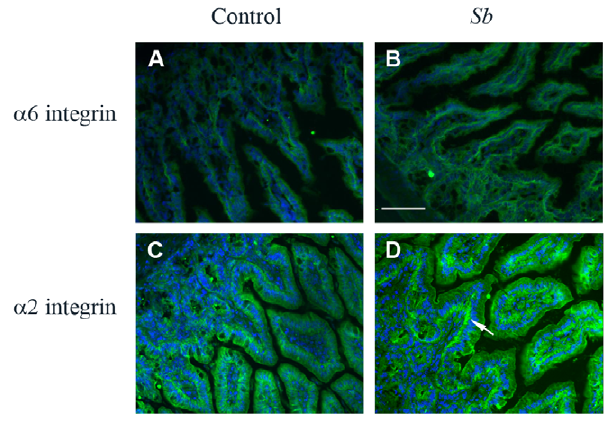
Figure 5. a 2 b 1 integrin is relocalized in the intestine of Sb force-fed mice. Intestinal tissues from control ( A and C ) or Sb force- fed mice ( B and D ) were immunostained with Abs against a 6 ( A and B ) or a 2 integrin ( C and D ). Each image is a representative image taken from tissue sections of five mice. Scale bar: 130 m m.